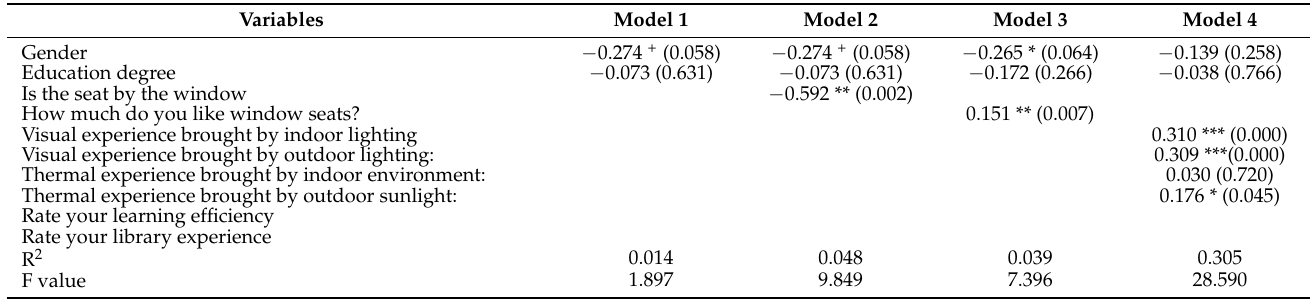
Table 3. Results of regression analyses (N = 280).